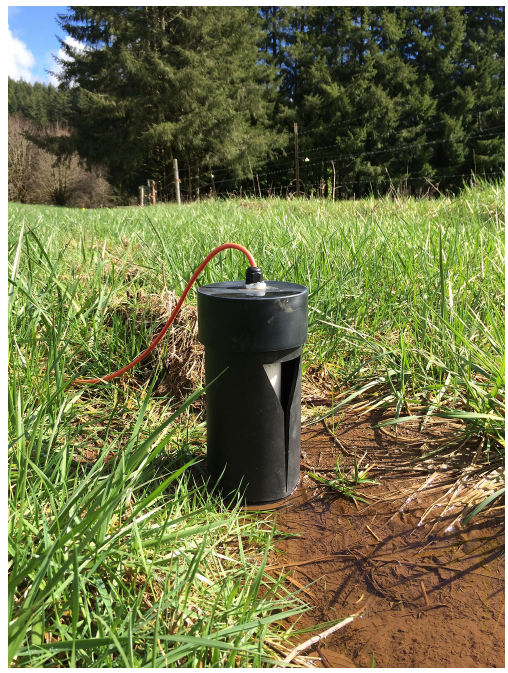
Figure 1. Field installation of a water level sensor inside a flow